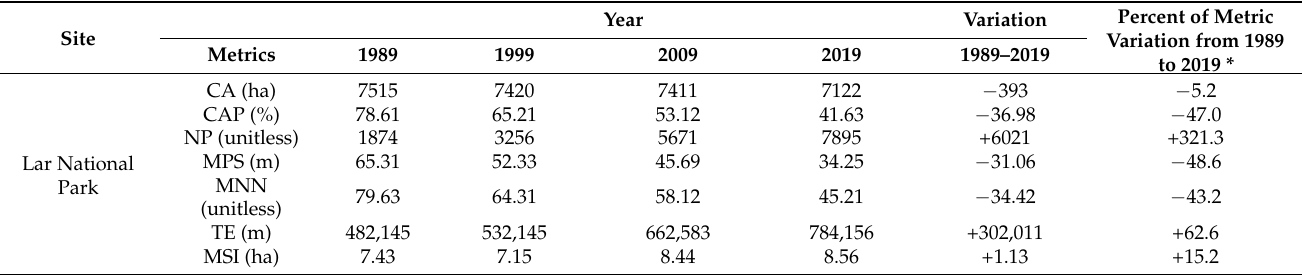
Figure 7. Percentage of LULC temporal changes in the studied areas from 1989 to 2019. Table 5. Changes in high-density pasture habitat metrics between 1989 and 2019 at the three